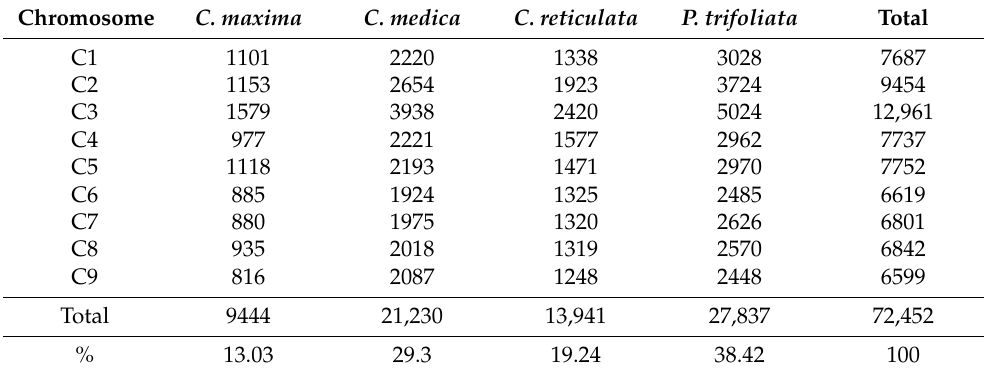
Table 1. Distribution of the 72,452 diagnostic SNPs (DSNPs) per taxon and per chromosome.